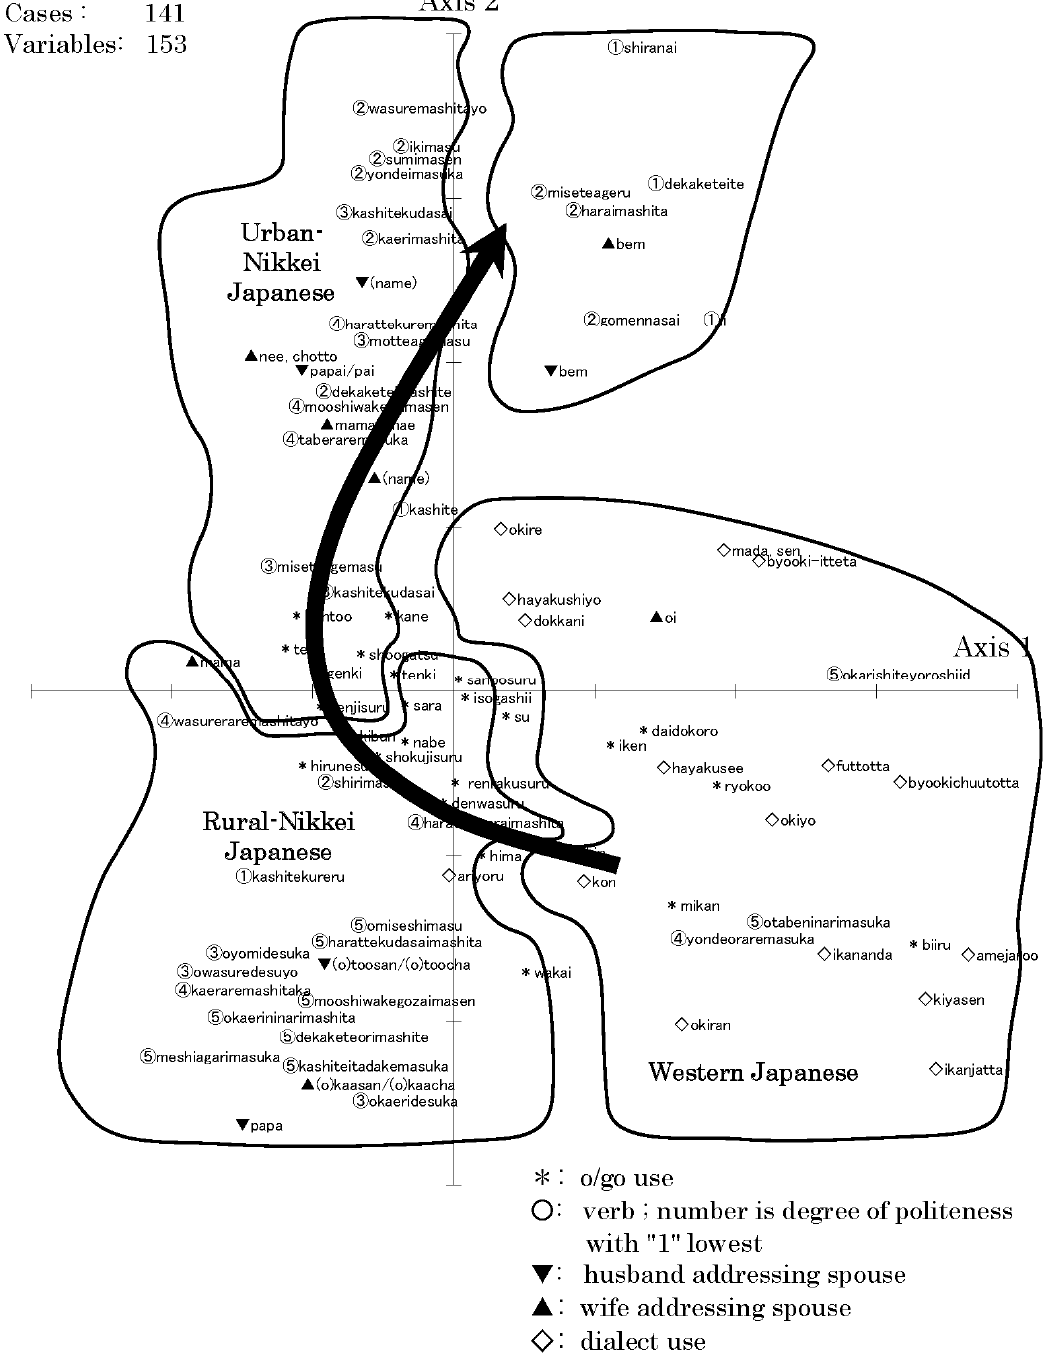
Figure 1. Figure of New Japanese language order in Nikkei-Brazilian communities.